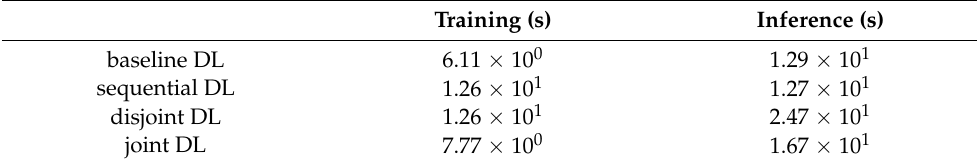
Table 5. The execution time for training and for inference for 1000,000